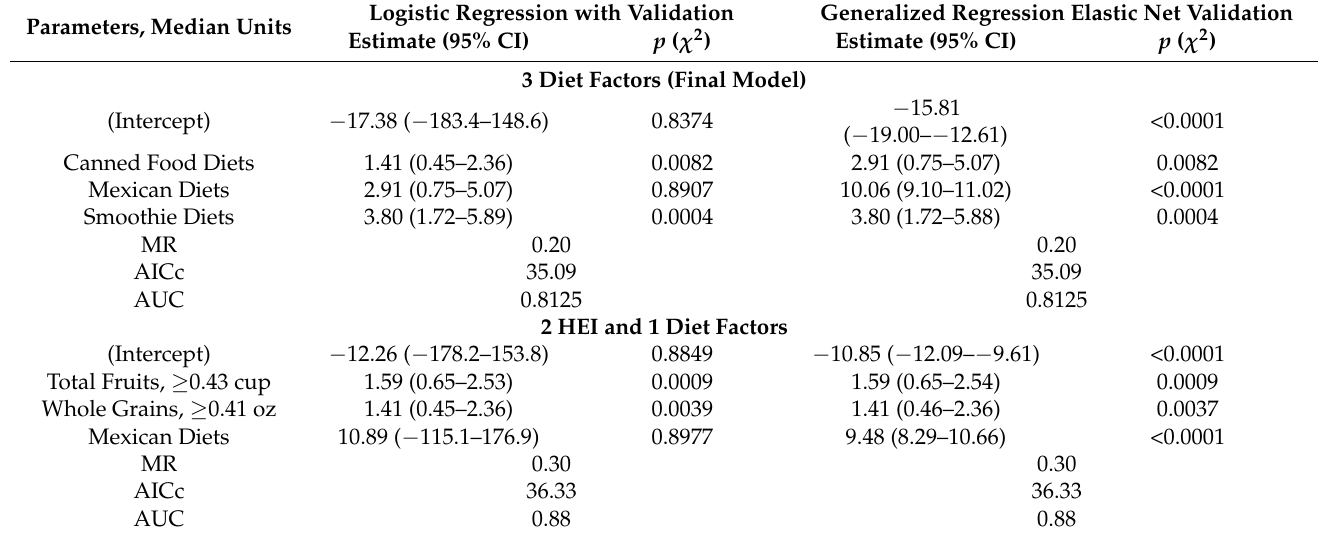
Table 5. Predictors of standardized carbohydrates per median number of meals ( ≤ 33.95 g) needed for glycemic load (GL) <